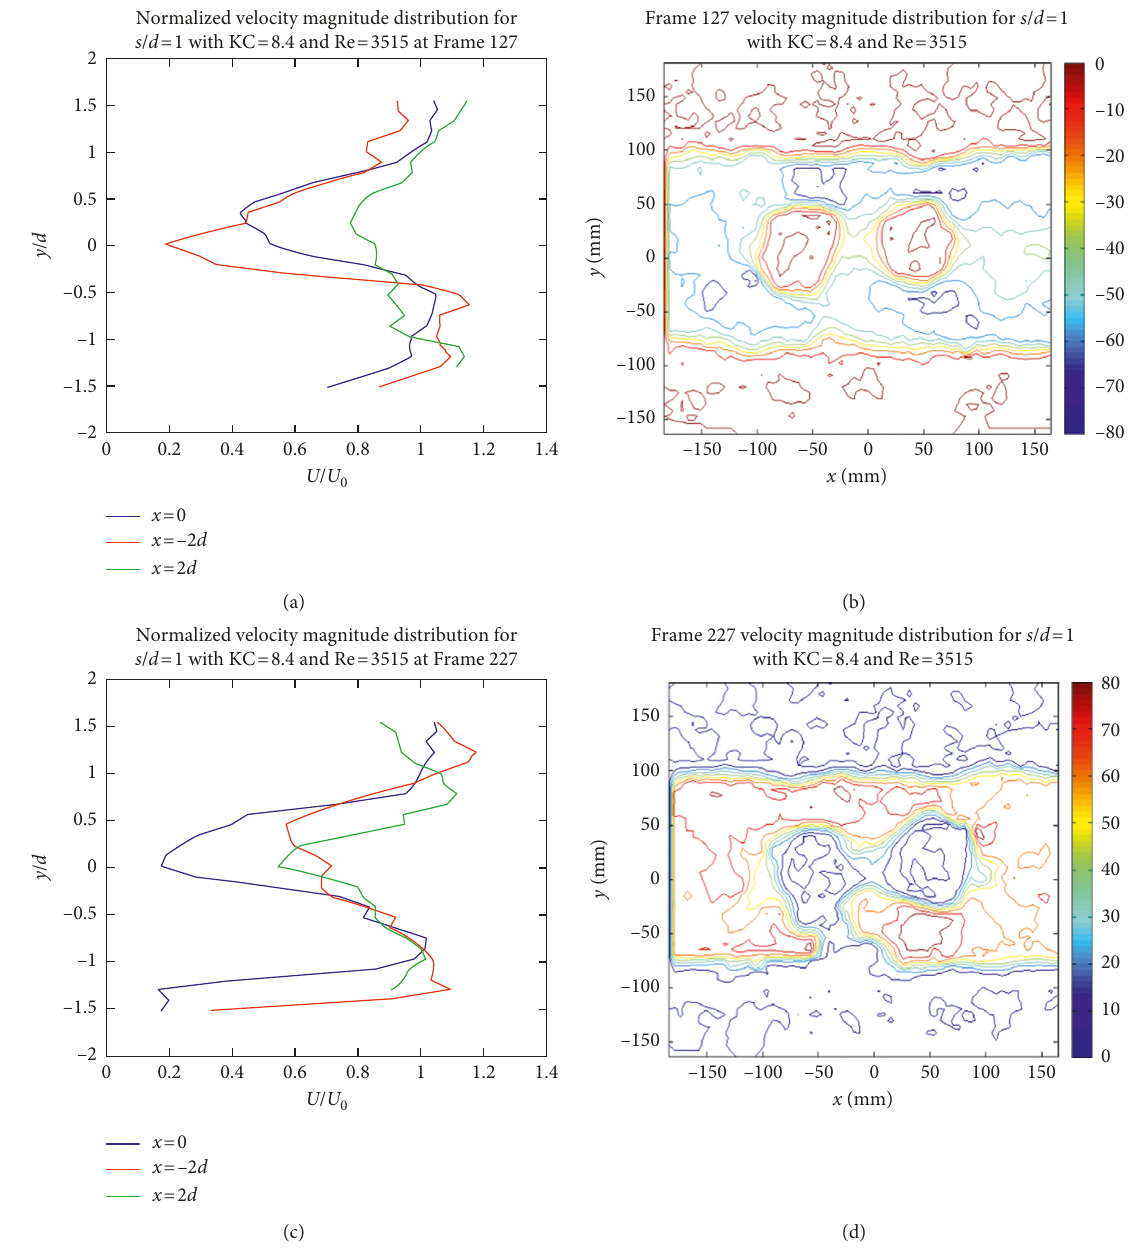
Figure 10: Normalized velocity and velocity contour when s/d � 1, Re � 3515.5, and KC � 8.4; (a) normalized velocity at Frame 127; (b) velocity magnitude contour at Frame 127; (c) normalized velocity at Frame 227; (d) velocity magnitude contour at Frame